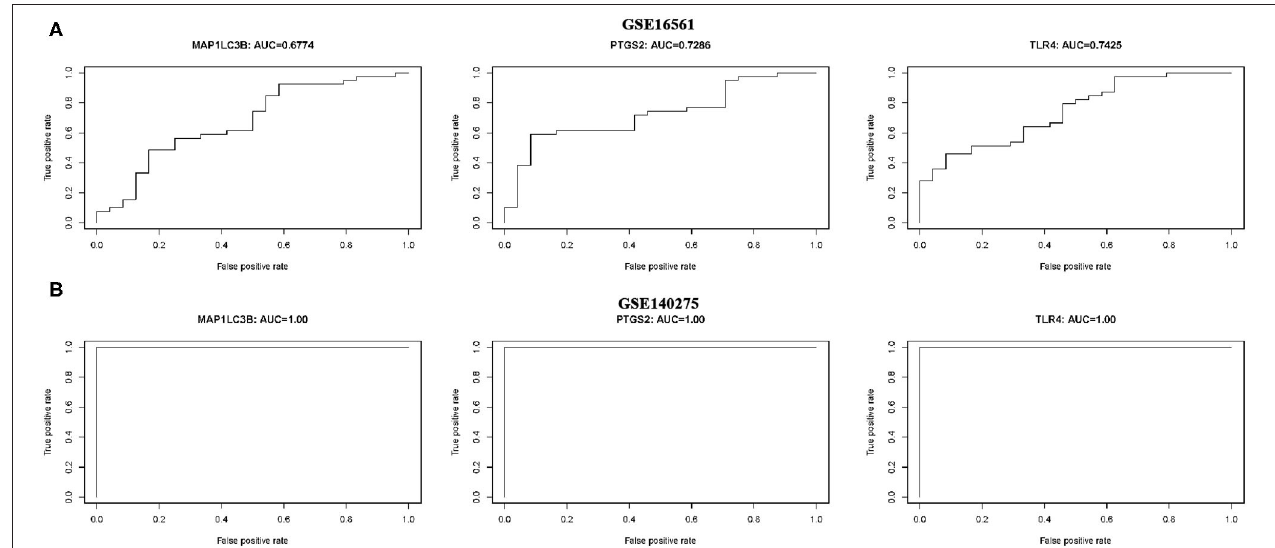
FIGURE 6 | ROC monofactor analysis revealed the diagnostic value of ferroptosis-related biomarkers in ischemic stroke. (A) The AUC of ferroptosis-related biomarkers in the diagnosis of ischemic stroke in ROC monofactor analysis in the GSE16561 dataset. (B) The AUC of ferroptosis-related biomarkers in the diagnosis of ischemic stroke in ROC monofactor analysis in the GSE140275 dataset.